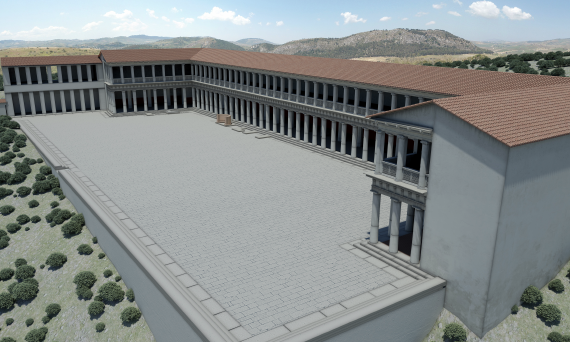
Figure 1. 3D model of the agora of